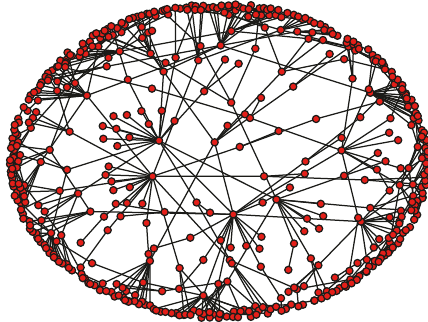
Figure 3: Coupling coefficient matrix 𝑀 AB .